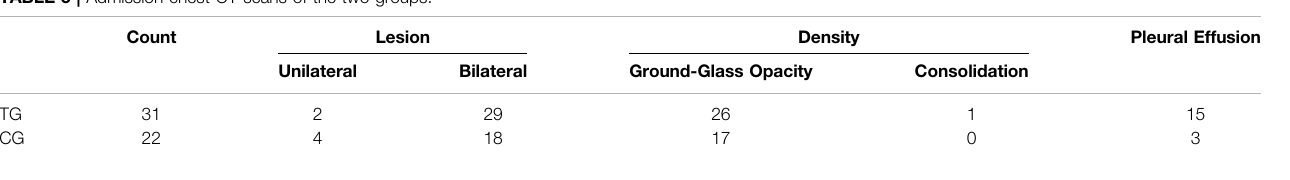
TABLE 5 | Admission chest CT scans of the two